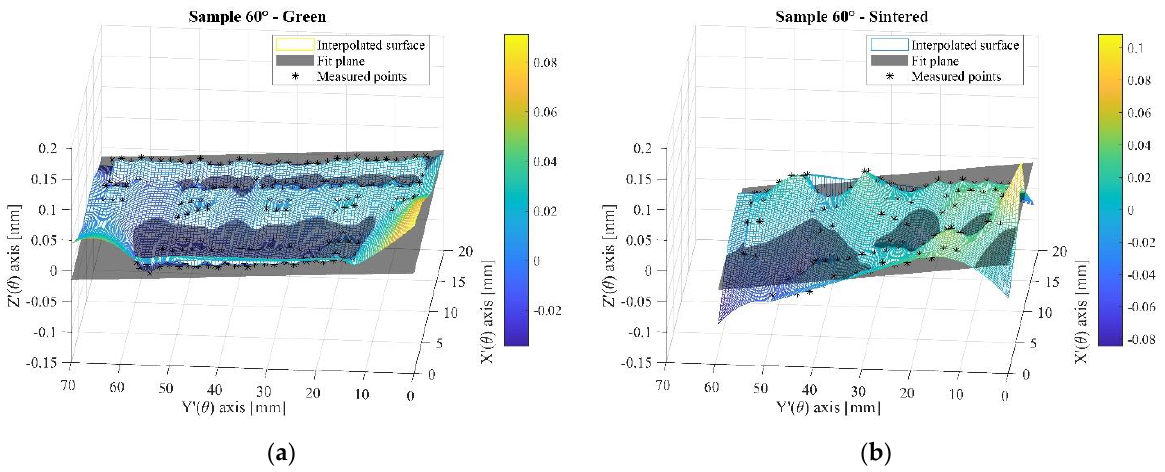
Figure 16. Sample 60° ( a ) points measured at the green state and reconstruction of the plane; ( b ) points measured at the sintered state and reconstruction of the plane.